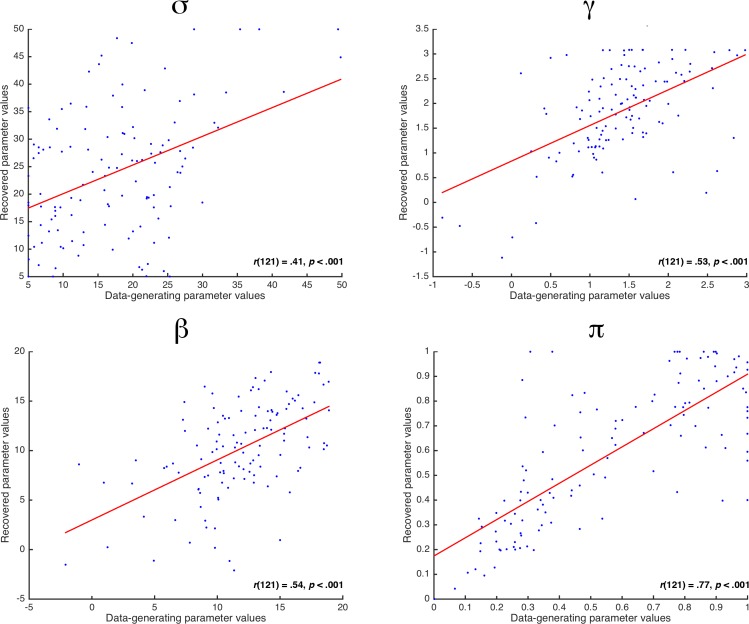
Model recovery results.Correlations between the data-generating and recovered parameter values for MIVAC’s four parameters. To create realistic testing conditions, the model recovery analysis used the estimated parameters of each participant and generated synthetic data for the 150 trials that were used to fit the model. σ=standard deviation of accumulation, γ = value based attentional capture, β = attention based enhancement of accumulation, π = probability to identify D as being unavailable.